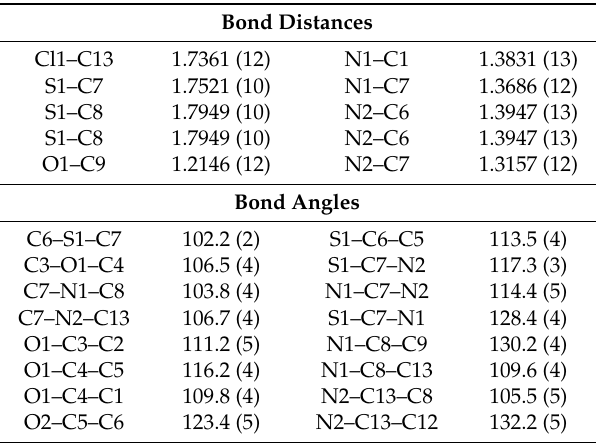
Table 3. Selected geometric parameters (Å, ˝ ) for compound 5v .